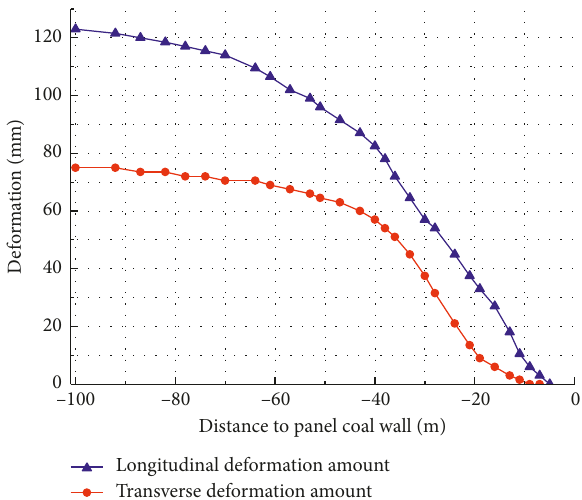
Figure 17: Relations between the deformation of the filling body beside the roadway and the distance from the working